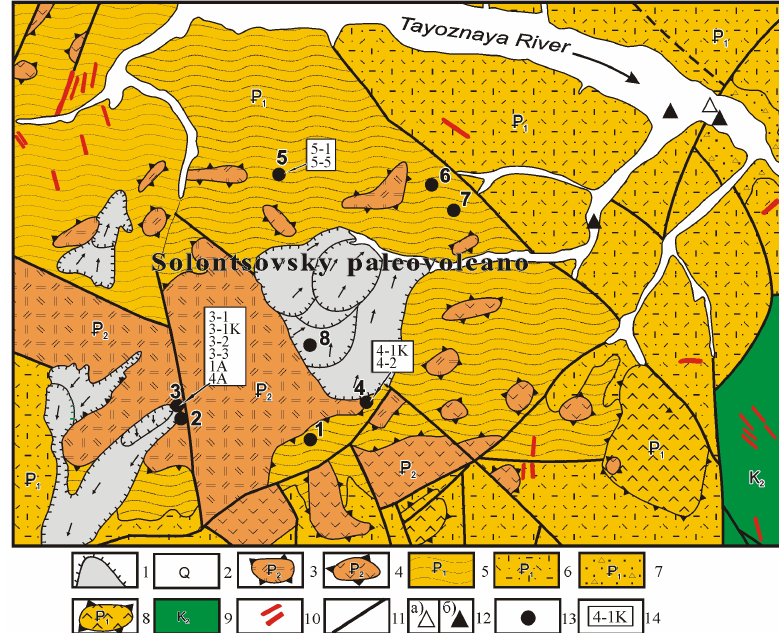
Figure 7. Geological scheme of the Solontsovsky palaeovolcano (Panichev et al., 2012, with additions): 1 – undivided Quaternary landslide deposits (arrows mark the direction of the slide motion); 2 – Quaternary alluvial deposits (sands, clay, gravels); 3–4 – Eocene extrusive bodies of trachyrhyolites (3) and dacites (4); 5–7 – Palaeocene volcanogenic and volcano-sedimentary formations of the Solontsovskaya unit: pelitic and psammitic tuffs of rhyolites with plant detritus, tuffites, tuff siltstones, tuffaceous sandstones with layers of banded silicites of the upper subunit (5); ignimbrites and welded tuffs of rhyolites, psammitic tuffs of rhyolites of the transitional subunit (6); ignimbrites and psephitic and psammitic tuffs of rhyolites, lower subunit tuffites (7); 8 – Palaeocene andesite; 9 – tuffs, tuffites, ignimbrites of the Primorsky Suite rhyolites, the Turonian and Santonian ages; 10 – Eocene andesite subvolcanic bodies and dikes; 11 – faults; 12 – archaeological sites of the Bronze (a) and Mesolithic (b) ages; 13 – kudurs; 14 – sampling